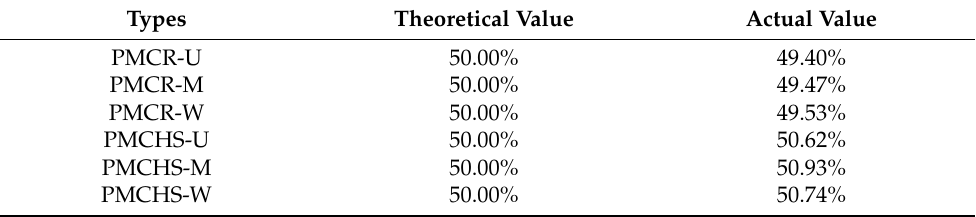
Table 1. The comparison of theoretical values and actual V f values of PMCRs and